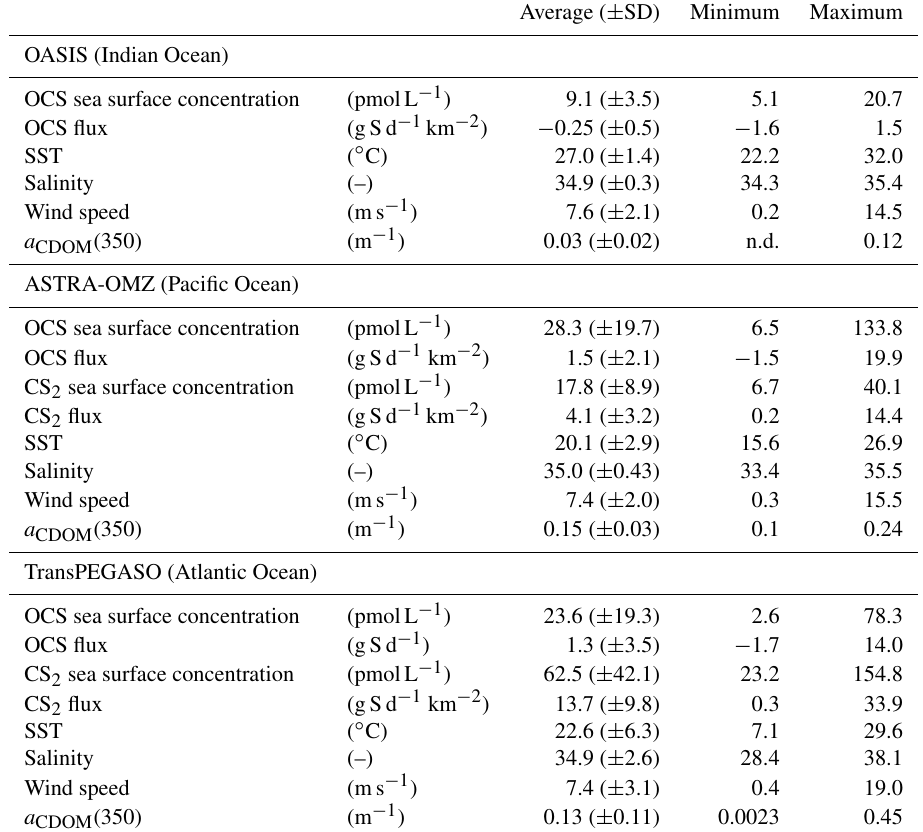
Table 3. Average, standard deviation and range of parameters observed during the cruises OASIS (Indian Ocean, 2014), ASTRA-OMZ (Pacific Ocean, 2015) and TransPEGASO (Atlantic Ocean,